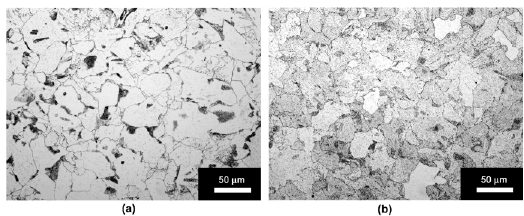
Figure 2: Microstructure of ferritic-pearlitic sample: (a) as received, (b) after 2000 h at 600°C.